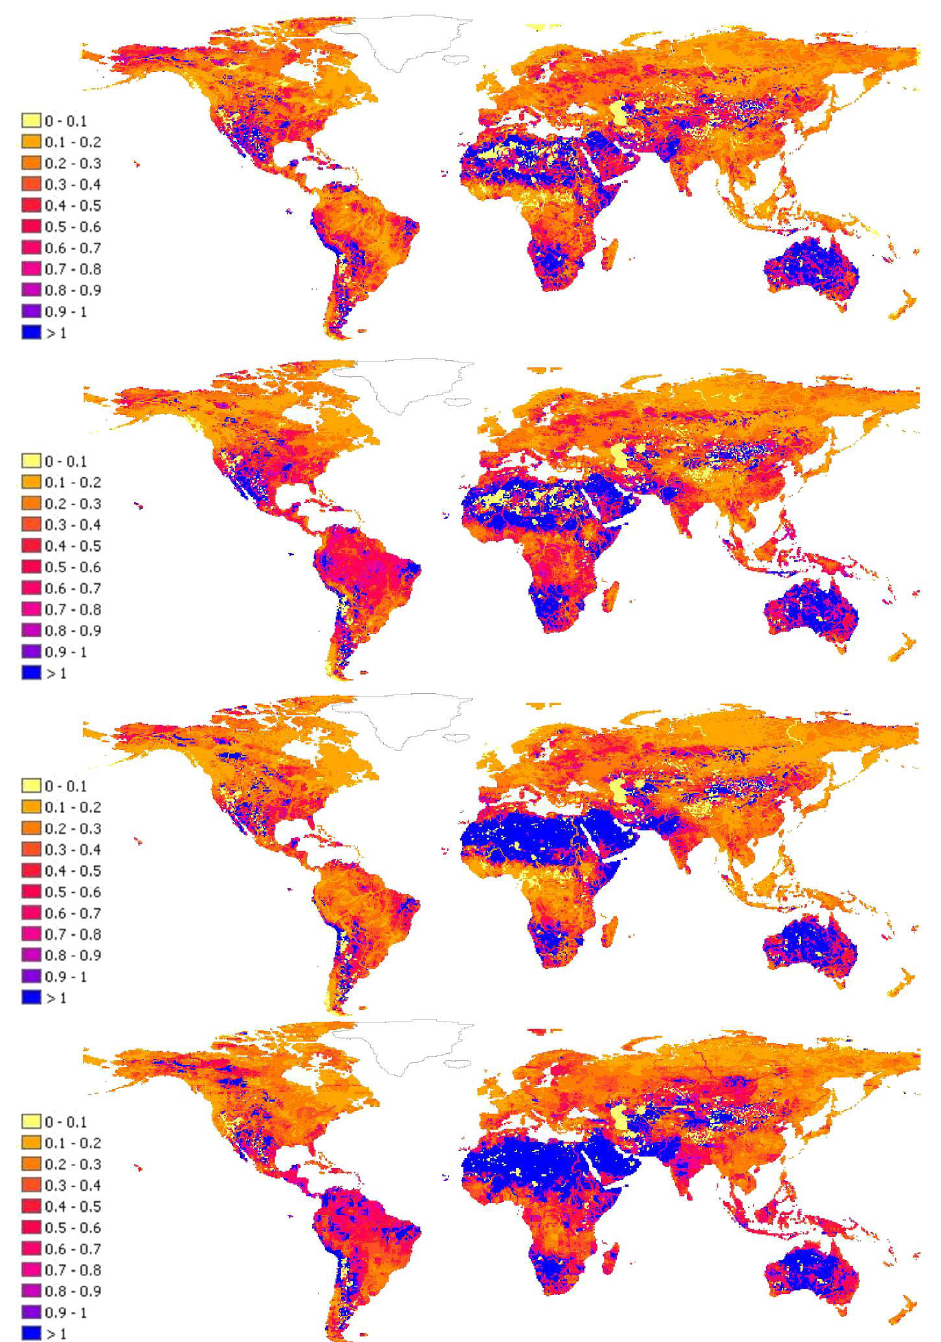
Figure 13: Thirty year average relative inter-annual variability: IAV/ Q (-) calculated from a)3 Fig. 13. Thirty year average relative inter-annual variability: IAV /Q (–) calculated from (a) the PCR-GLOBWB run forced with the the PCR-GLOBWB run forced with the ERA6190 dataset, b) the PCR-GLOBWB run forced4 ERA6190 dataset, (b) the PCR-GLOBWB run forced with the ERACLM dataset, (c) the ensemble mean discharge results of the 12 GCM based PCR-GLOBWB runs and (d) the CV (–) of the IAV of the ensemble of GCMs. with the ERACLM dataset, c) the ensemble mean discharge results of the 12 GCM based5 PCR-GLOBWB runs and d) the CV (-) of the IAV of the ensemble of GCMs.6 timing of peak discharge that coincides with the monsoon the year and the seasonality of the regime, with a low end instead of snow melt in spring, and (2) the Orange, where of summer baseflow, is less the average ERA6190 regime is more constant throughout